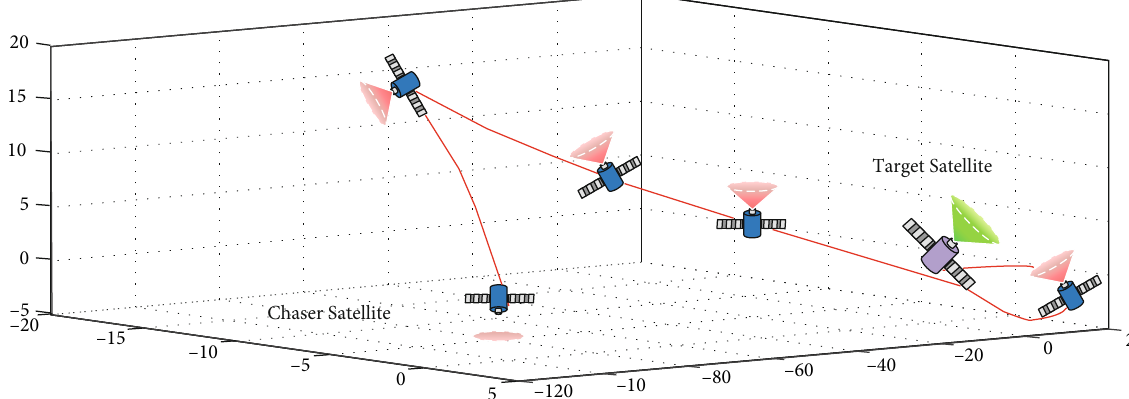
Figure 11: 3-D overall trajectory of close proximity maneuver via MPC with prediction horizon with the prediction of 15 sampling